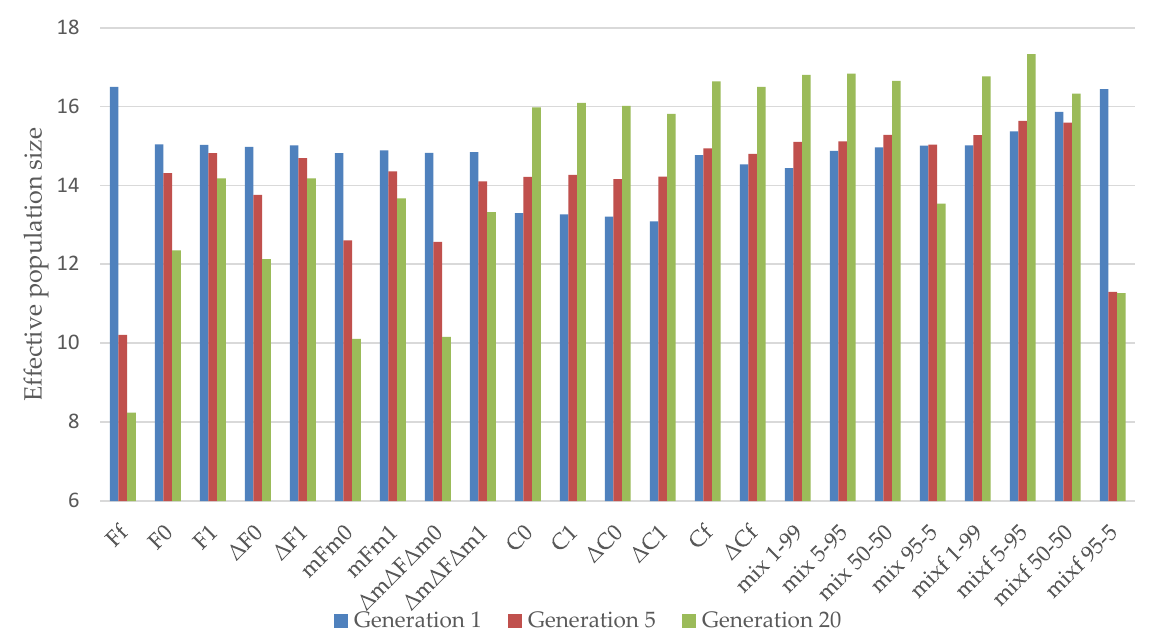
Figure 1. Effective population size obtained by the different strategies in the reference population of Almería in 1, 5, and 20 generations. (Ff, F0, and F1) based on minimum coancestry of the parents; (ΔF0 and ΔF1) based on increment in coancestry of the parents; (mFm0 and mFm1) based on weighted coancestry; (ΔmΔFΔm0 and ΔmΔFΔm1) based on weighted increase in coancestry; (C0, C1, and Cf) based on coancestry of the offspring; (ΔC0, ΔC1, and ΔCf) based on increase in coancestry of the offspring; (mix 1–99, mix 5–95, mix 50–50, mix 95–5, mixf 1–99, mixf 5–95, mixf 50–50, and mixf 95–5) mixing information from the parents’ coancestry and offspring’s coancestry.